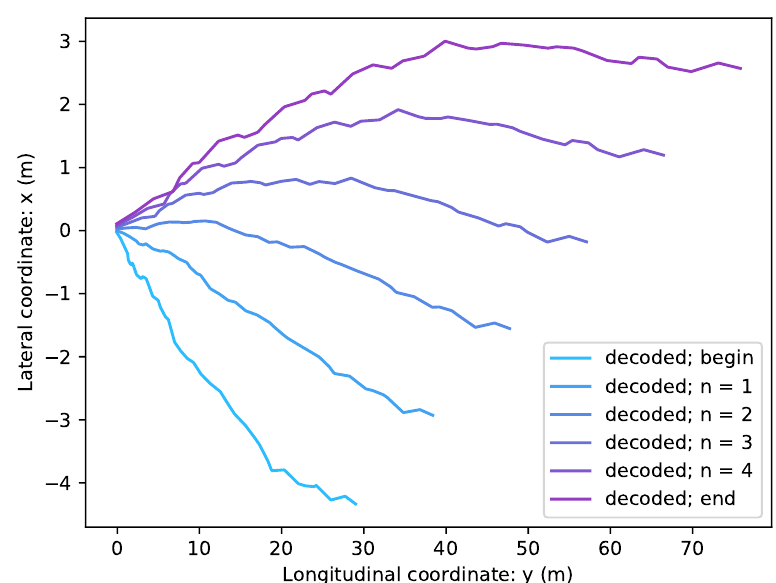
Figure 7. An interpolation between two different maneuvers is visualized. The series of trajectory plots begin with a right lane change and ends with a left lane change. There are three internal states that are the result of decoding the weighted average of the context vectors of the two extreme states. The continuous transition illustrates the well-organized nature of the latent space generated by the